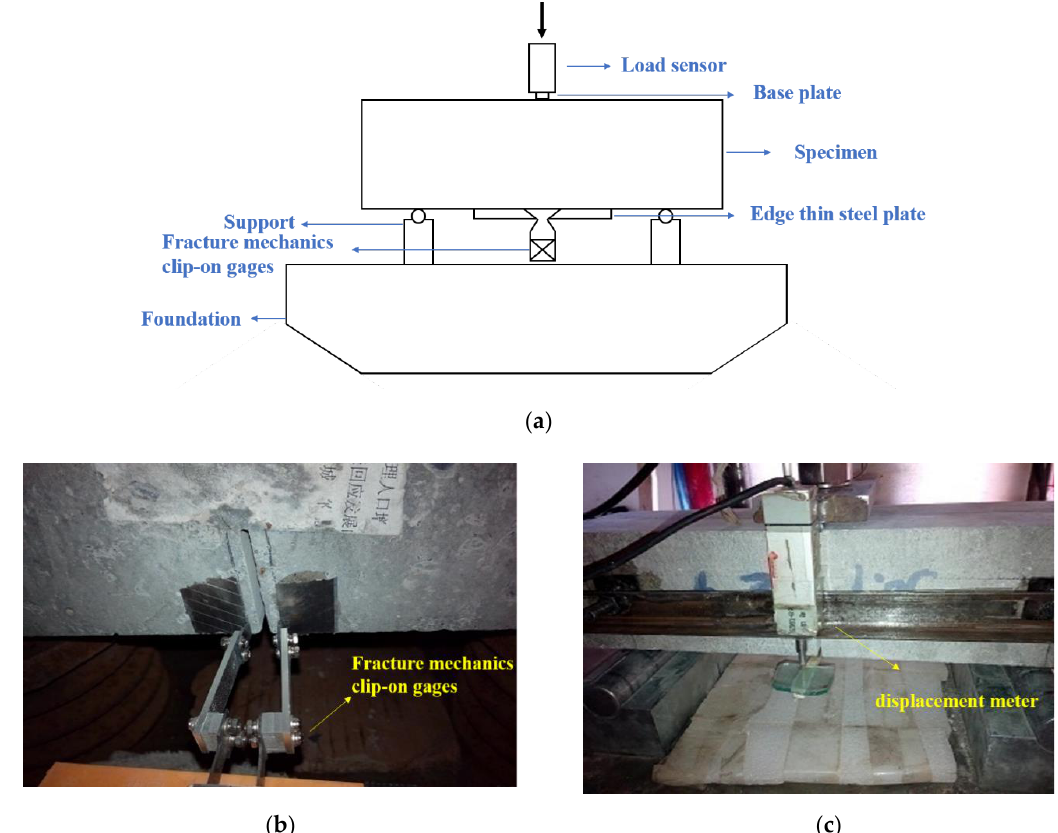
Figure 2. Fracture experiment process of three-point bending beam. ( a ) Diagram of three-point bending fracture test, ( b ) fracture mechanics clip-on gages, ( c ) displacement meter.